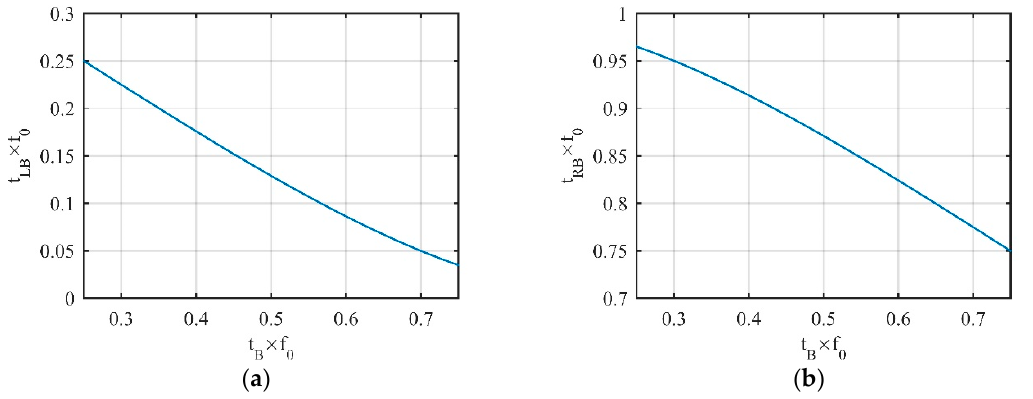
Figure 5. Change laws of ( a ) t LB and ( b ) t RB with t B .